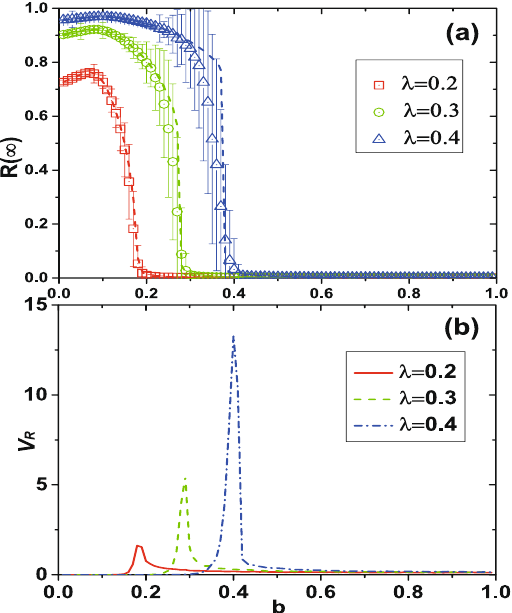
Figure 4. Illustration of effects of dynamical parameter λ with arbitrary b , where λ is behavior transmission probability and b is LTI capacity parameter. ( a ) Under different λ , the change pattern of R ( ∞ ) with b shows a first increase and then a decrease. Ultimately, the R ( ∞ ) vanishes to zero. ( b ) To find the critical point where the R ( ∞ ) vanishes, v R is introduced here. Besides, the peaks of v R lines correspond to critical points, and the higher the peaks the sharper the jump to